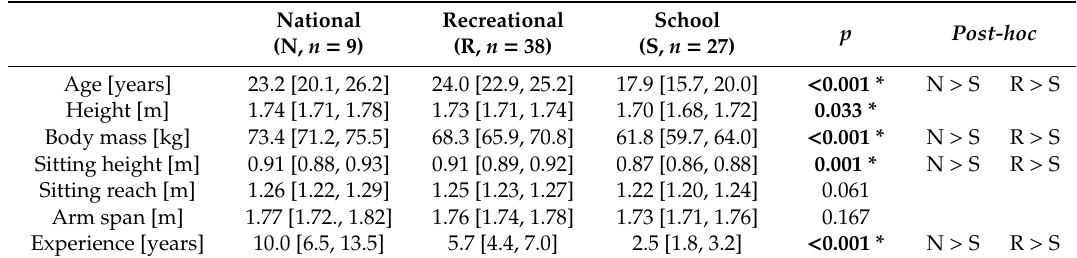
Table 1. Physical characteristics and experience of 74 male K2 sprint kayaking athletes from the national team, recreational clubs, and school